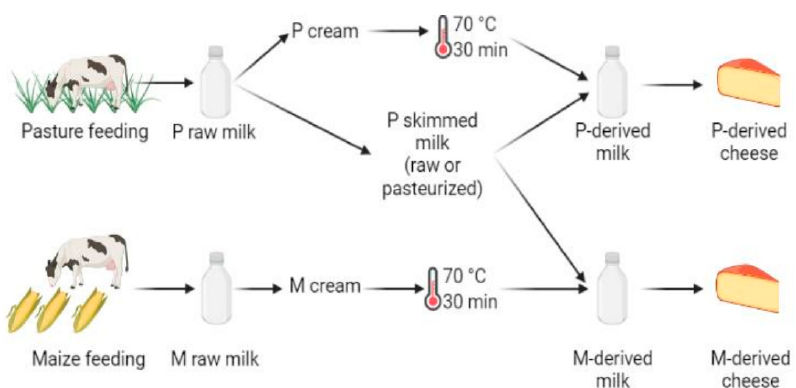
Figure 1. Experimental design, performed in triplicate. The following samples were used for DNA metabarcoding analyses: P- and M-derived raw milk, unripened P- and M-derived cheese (i.e., day (D)3), P- and M-derived cheese rinds at D30 and D90 of ripening, P- and M-derived cheese rinds at the end of ripening (i.e., D150) and P- and M-derived cheese cores at D150 (figure created using BioRender.com, accessed on 4 November 2021)).